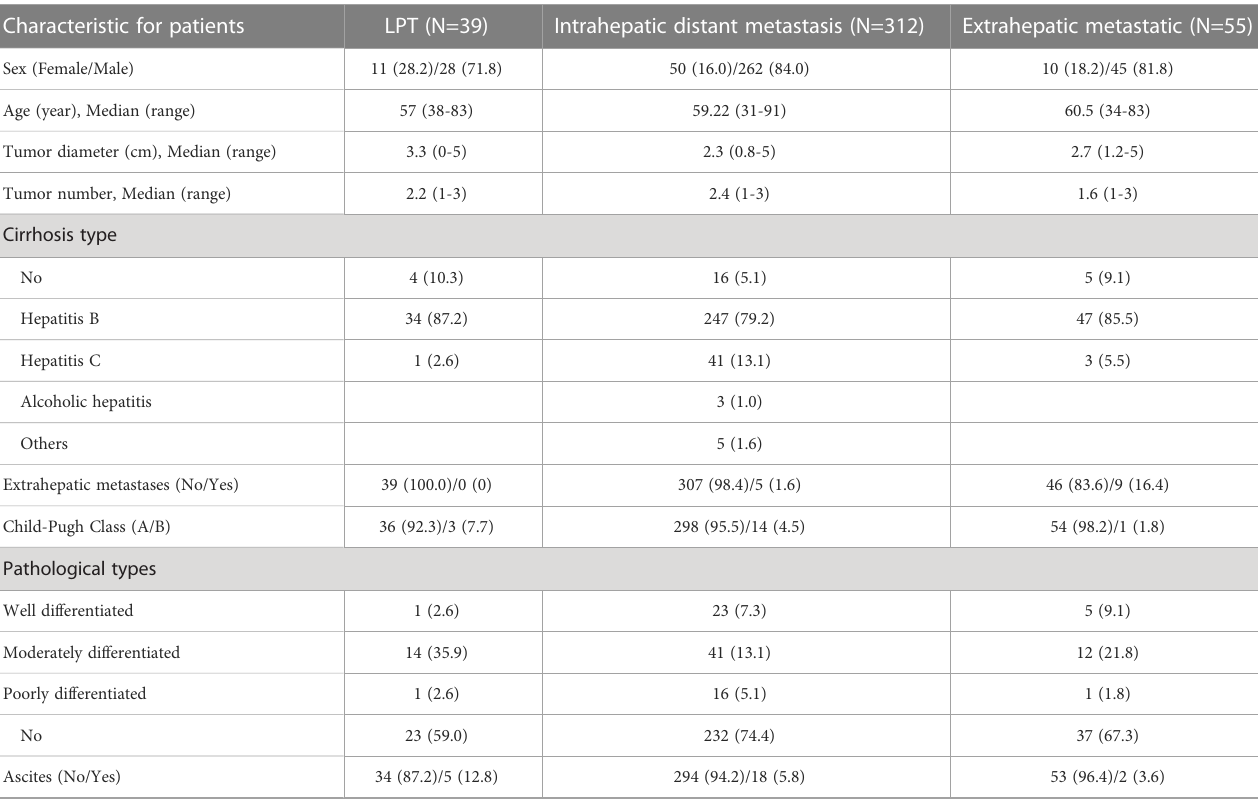
TABLE 2 Characteristics and outcomes for different recurrence patterns. Characteristic for